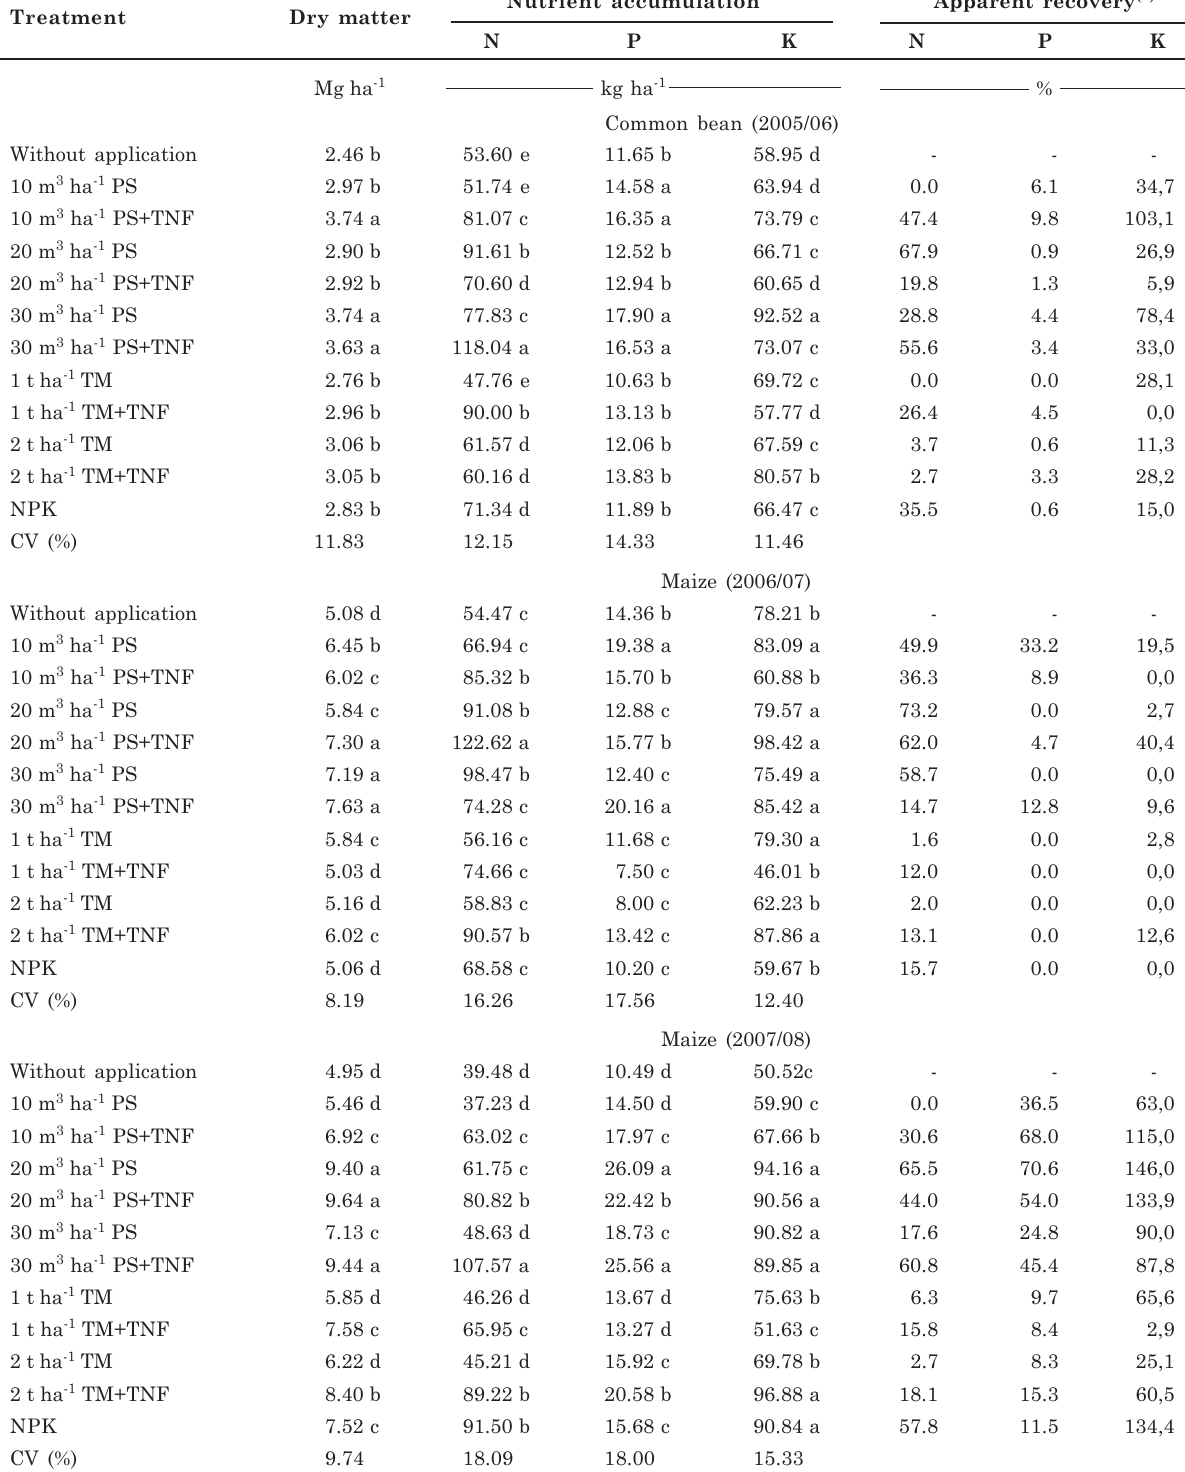
Table 3. Dry matter, nutrient accumulation and apparent recovery of nutrients by the aerial part of common bean and maize subjected to organic and mineral